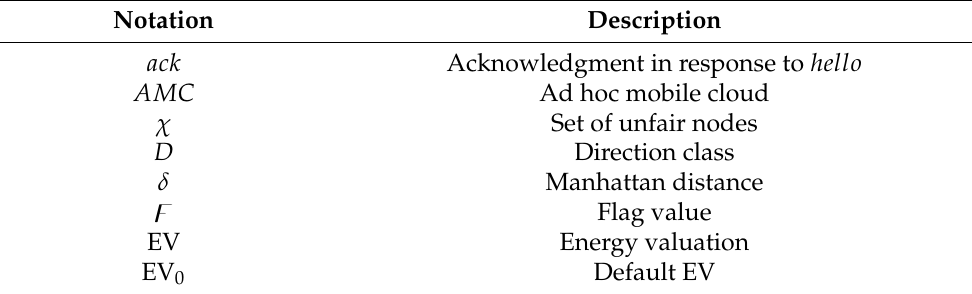
Figure 2. The proposed MACRS framework. Table 3. List of